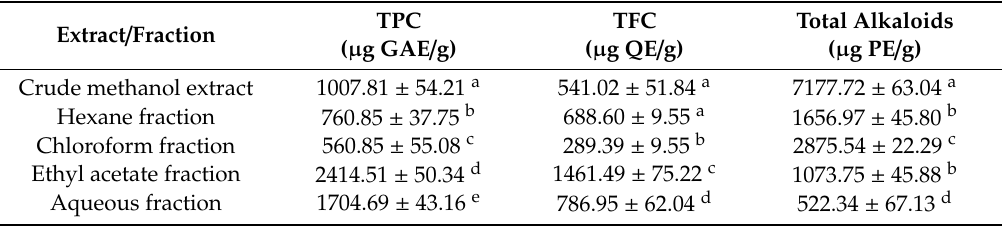
Table 1. Phenol, flavonoid, and alkaloid contents of crude methanol extract and fractions of Gracillaria